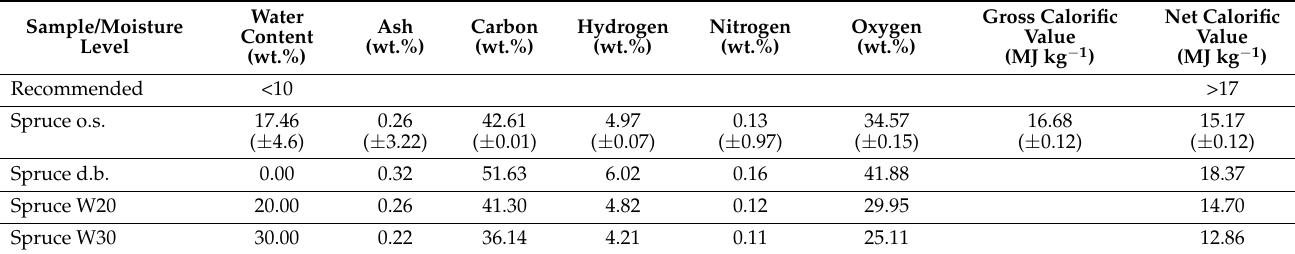
Table 1. Composition and calorific values of spruce